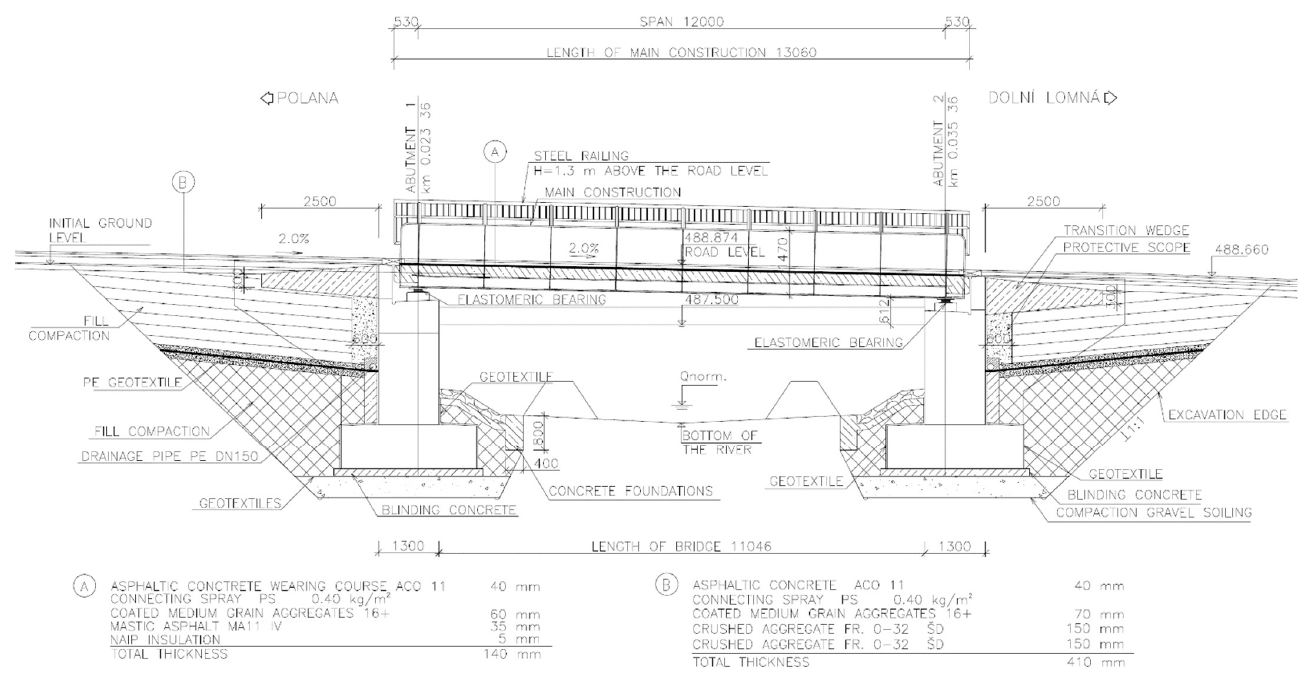
Figure 6. Longitudinal section of SCB bridge (scale 1:100).